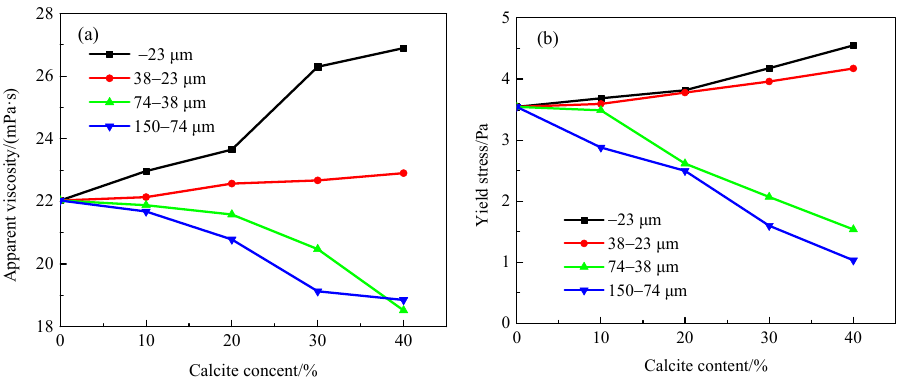
Figure 7. Effects of particle size on pulp’s ( a ) apparent viscosity and ( b ) yield stress of the mixed mineral of smithsonite-calcite using octadecylamine concentration: 150 mg/L at pH 9.5–10 and 28.57% solid concentration.